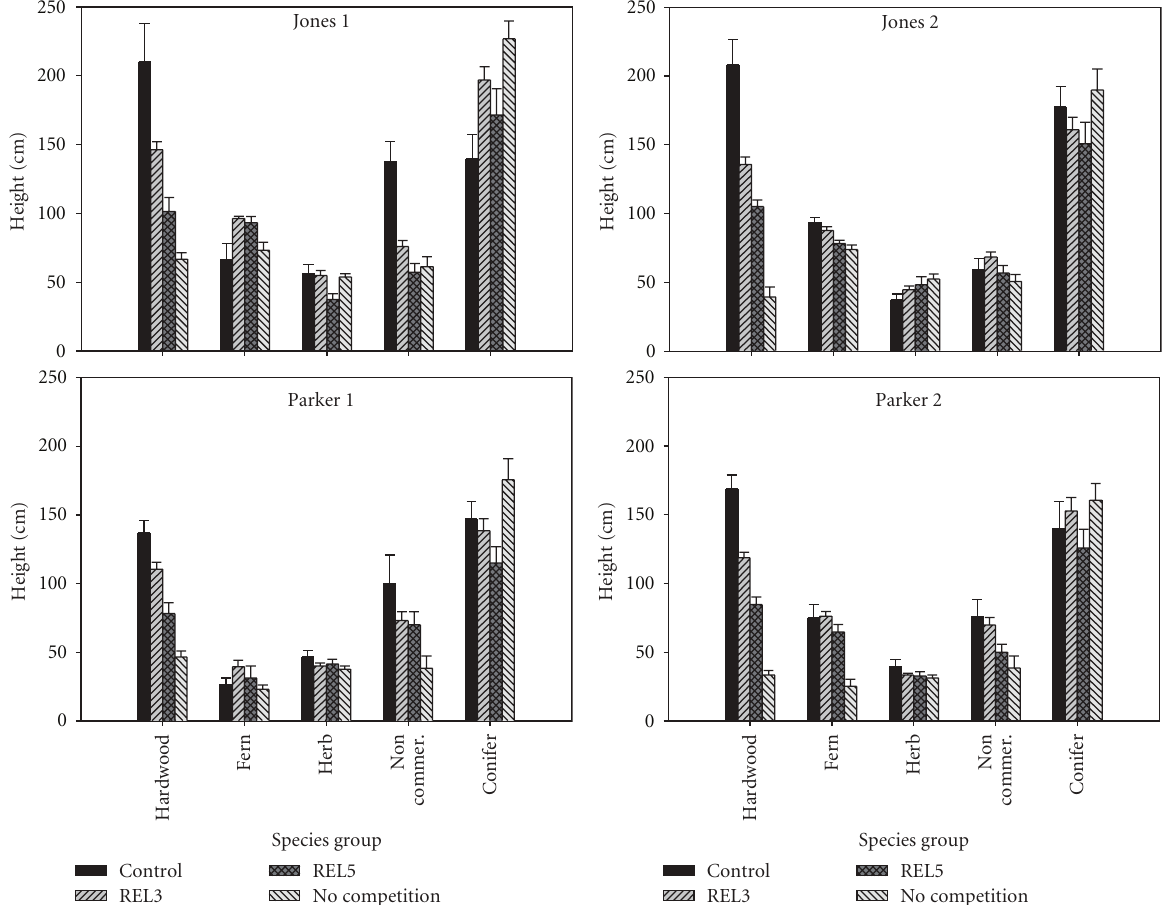
Figure 2: Average modal height ( ± standard error) of the principal groups of competing vegetation, as evaluated during the eight growing season following planting of four experimental Picea glauca plantations established in south central Quebec (Canada). See Table 1 for a detailed description of each vegetation group. Treatments consisted of four intensities of vegetation management including a control, mechanical release during the third growing season (REL3), mechanical release during the fifth growing season (REL5), and plots where competition for light was eliminated through repeated herbicide and mechanical release treatments (No competition: NC). Treatment e ff ects were consistent across sites (refer to Table 2 for detailed ANOVA results). Data are presented separately for each site for clarity and